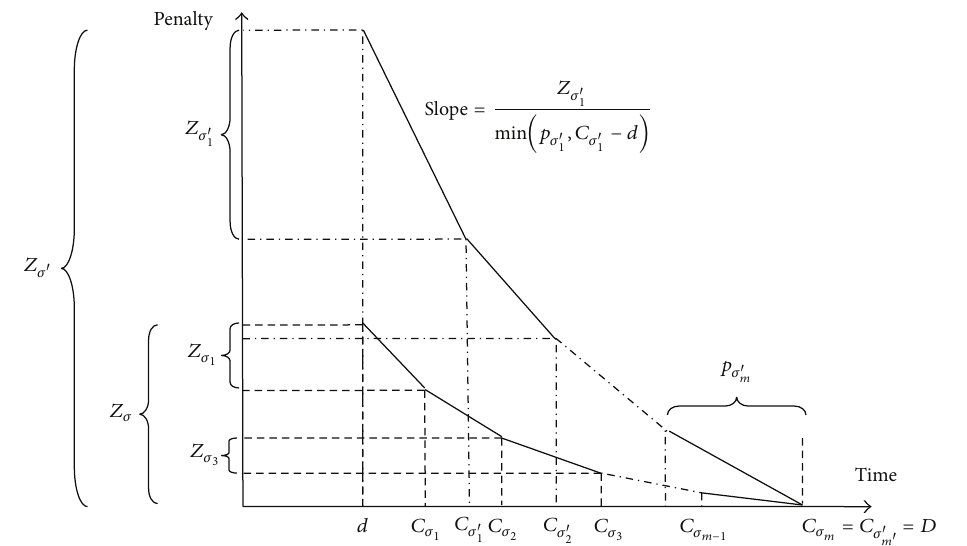
Figure 2: Penalties related to sequences 𝜎 and 𝜎 󸀠 .